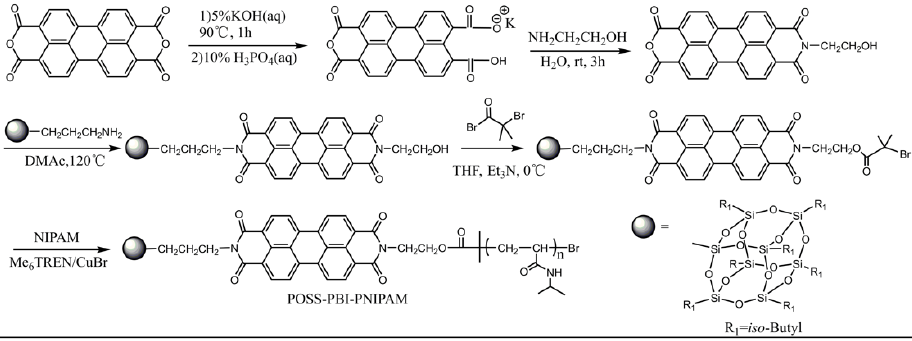
Figure 6. Synthetic procedure of PProDOT-POSS [75]. 2.3. POSS-Based QDs Fluorescent Materials Quantum dots (QDs) are fluorescent semiconductor nanoparticles composed of groups II–VI or III–V elements with a diameter of 2–10 nm [76–78]. QDs have unique optical and electronic properties due to the quantum confinement effects. However, the practical applications of QDs are impeded by their water solubility and toxicity. The de- velopment and search for novel ligands for QDs providing them desirable functionali- ties constitutes a hot research field nowadays [79]. In 2013, the POSS-based CdSe quan- tum dots, denoted as POSS-CdSe QDs , were reported by Rogach and co-workers (Fig- ure 7a) [80]. They synthesized the QDs using a mercapto-substituted polyhedral oligo- meric silsesquioxane (POSS-SH) as ligand. Due to the bulkiness of the siloxane core, the POSS-CdSe QDs had adjustable particle size and improved light-emission characteris- tics (Figure 7b). The absorption and photoluminescence (PL) spectra were used to moni- tor the growth kinetics of POSS-CdSe QDs in chloroform. After 2 min of growth, the size of particles was 1.8 nm with a characteristic absorption maximum at 430 nm and a broad PL spectrum (near-white light emission). The absorption maximum shifted to 527 nm after 3 min of growth with the size of particles 2.8 nm, the narrow PL peak in the green spectral range. After 10 min of growth, the size of particles was 3.7 nm with the emission color of the growing samples gradually changed from green to red. Subse- quently, low toxicity near-infrared-emitting QDs were fabricated in aqueous medium by conjugating octa-aminopropyl polyhedral oligomeric silsesquioxane (OA-POSS) to CdSeTe QDs through condensation reaction, namely POSS-CdSeTe QDs (Figure 8a) [81]. The POSS-CdSeTe QDs had improved biocompatibility and retained the unique photophysical properties of CdSeTe quantum dots, in which the PL peak reached 681 nm with a quantum yield of 0.26 (Figure 8b). The toxicity of CdSeTe quantum dots to living cells was significantly reduced by covering the surface with OA-POSS. These re- sults indicated that POSS-CdSeTe QDs were very promising fluorescent labels in the biomedical field.